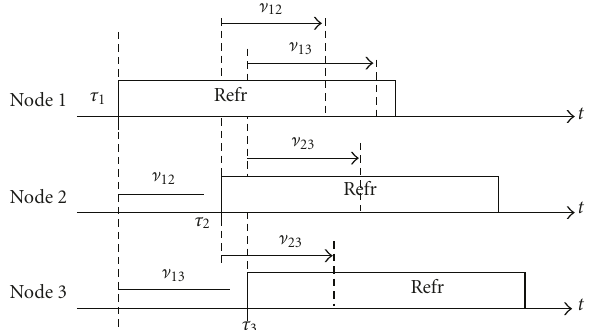
Figure 3: Synchronization of three pulse-coupled oscillators with